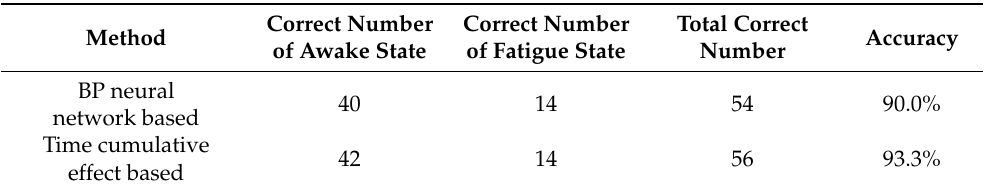
Table 5. Comparisons of fatigue detection results of the BP neural network model and the proposed time accumulation model for scenario 1.